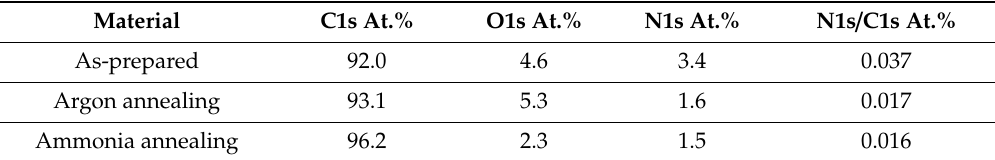
Table 3. XPS semi-quantitative analysis recorded on as-formed materials, and annealed materials under argon and